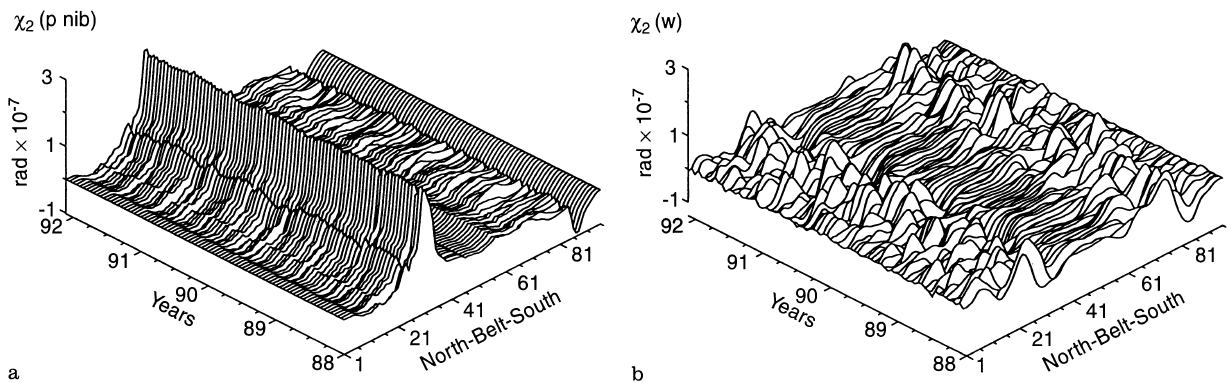
component of the zonal EAAM (JMA) excitation functions in 96 2